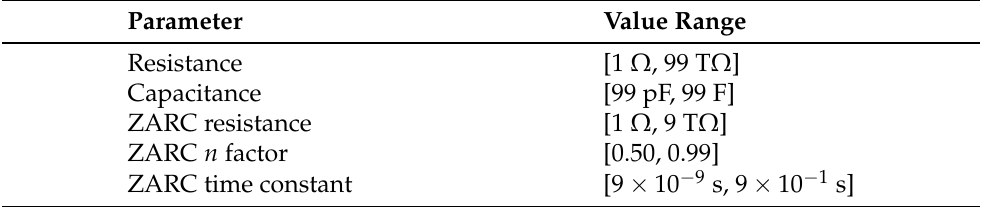
Table 2. Feasible value